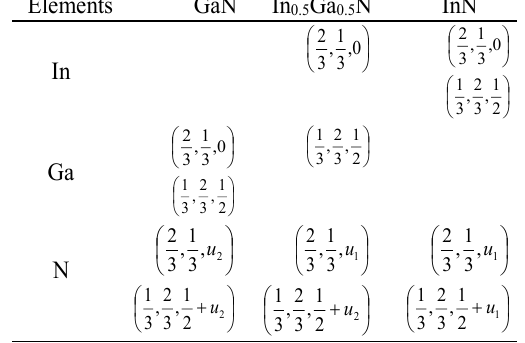
Table1. Positions in crystal coordinates for the elements of GaN, In Ga N and InN. 0.5 0.5